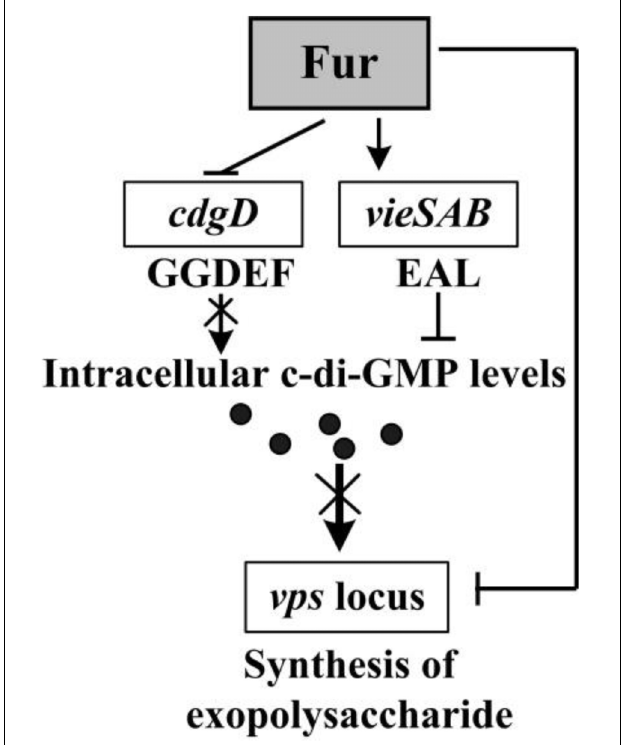
FIGURE 6 | Regulatory circuit. The arrows and lines indicate positive regulation. The T-junctions indicate negative regulation. The regulatory details are described in the main text. The intersection lines indicated that the cellular pathways were disrupted. The black dots indicated